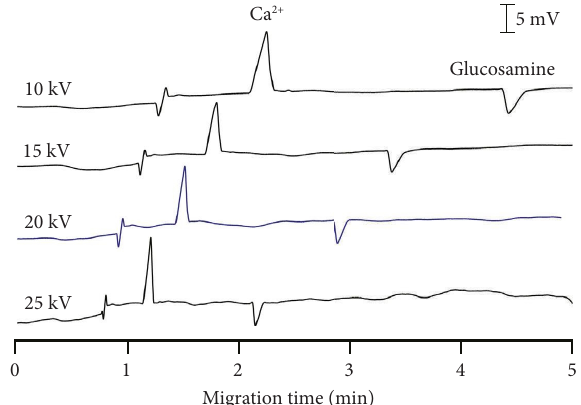
Figure 2: Efects of separation voltages on the CE-C 4 D analysis of glucosamine and calcium.BGE conditions:10mM Tris/Ace, pH 5.0, sample injection time of 30 s, sample injection height of 25cm. Te selected condition was highlighted in blue.